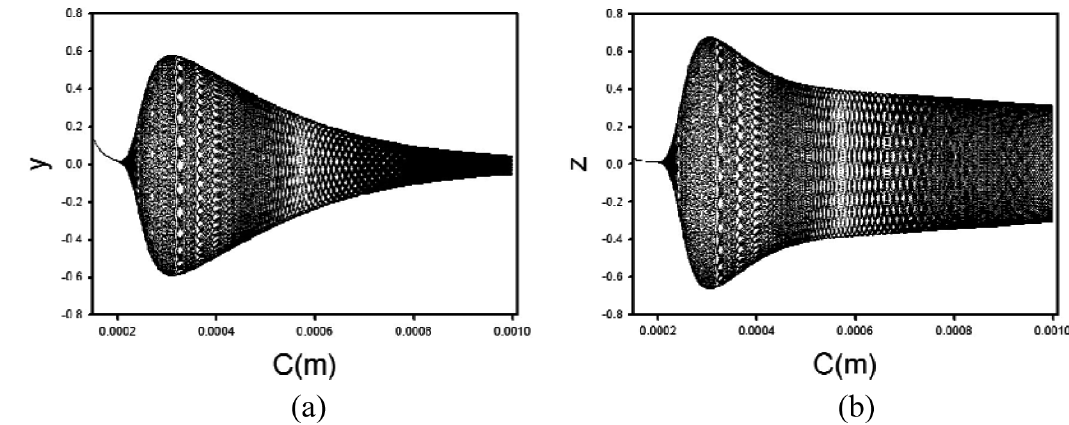
Fig.20. Thebifurcation diagram of displacements at the mid-span point versus mean clearance of bearing. (a) y -displacement; (b) z -displacement. D = 0.2 m, ω = 600 rad/s, γ m = 300 T 2 m/H, ρ s = 7800 kg/m 3 , E = 206 GPa, C e = D /1600, L = 3 m, L b = D /4, e ¯ m = 0 . 0001 m, x a = 0.08, x b = 0.92, μ o = 0.001 Pa ·